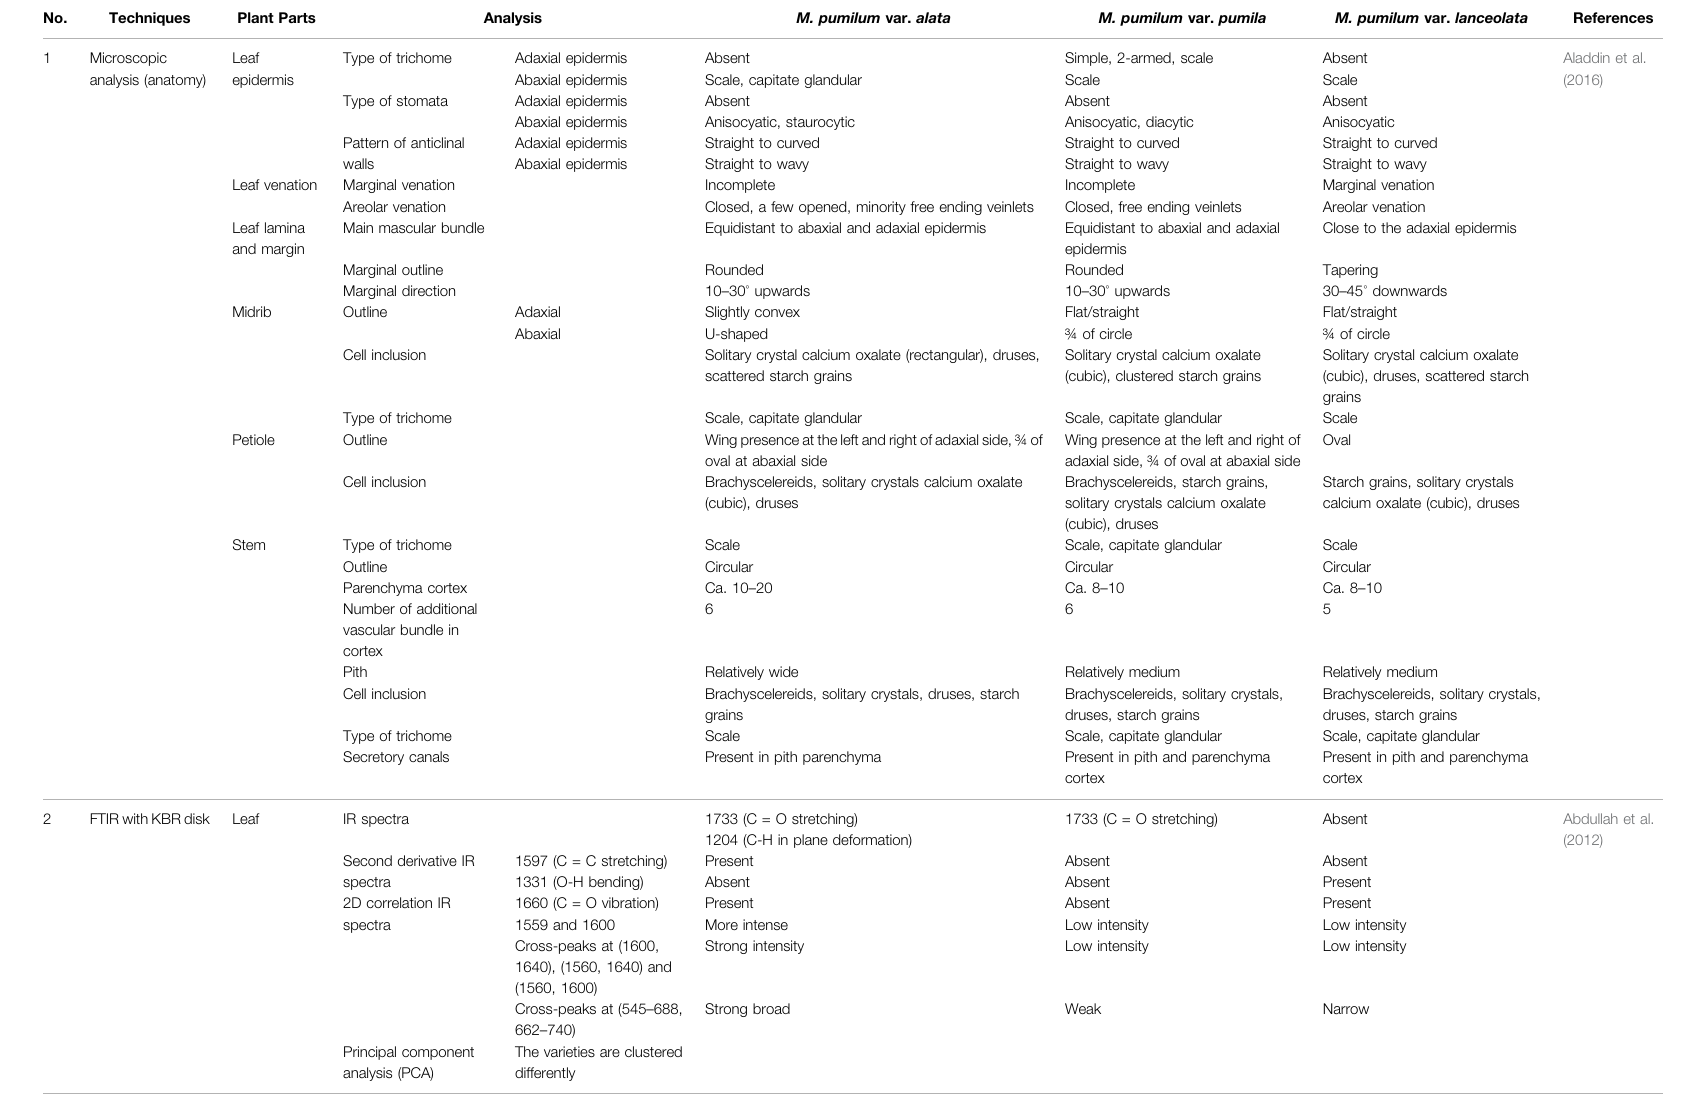
TABLE 2 | Characteristic features to distinguish Marantodes pumilum varieties based on different analytical